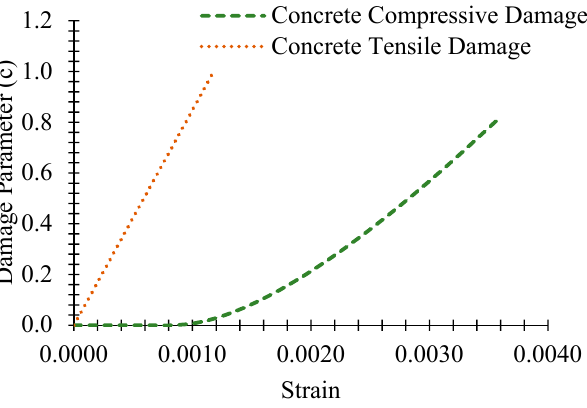
Figure 4. Damage parameter variation with strain for M30 grade of concrete.